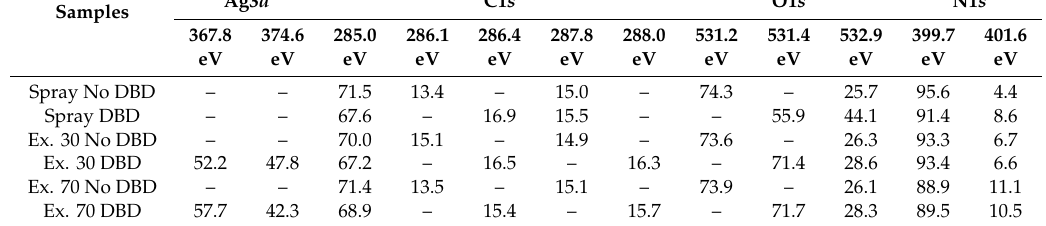
Table 2. Results of the deconvolution analysis of the C1 s , N1 s , O1 s and Ag3 d peaks for the untreated and DBD plasma-treated PA66 fabrics with AgNPs deposited with spray and exhaustion at 30 ◦ C and 70 ◦ C methods. Reported binding energies have an associated error of ± 0.1 eV.